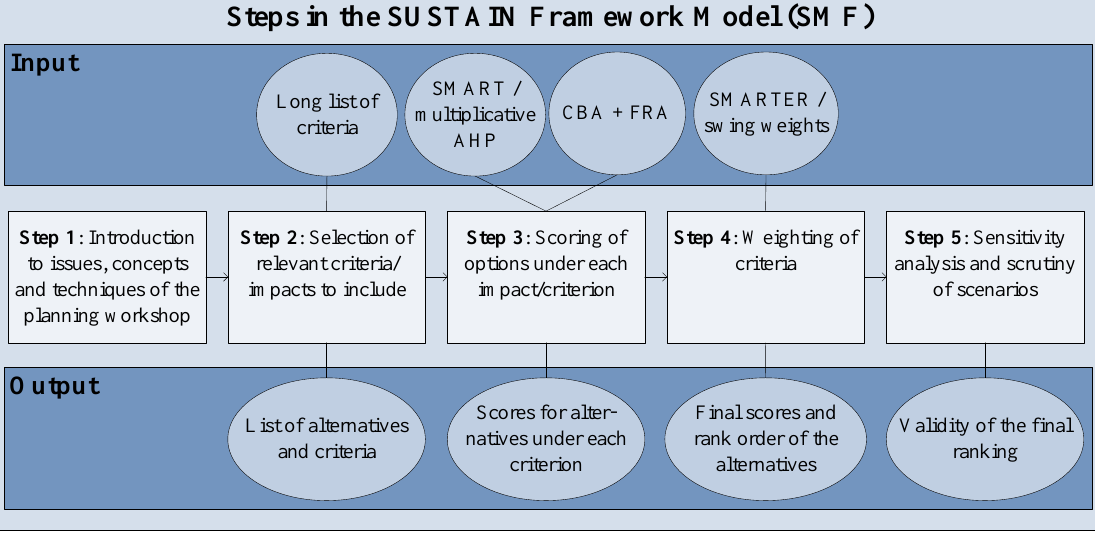
Figure 4. The 5 steps of the Framework model (adapted from Barfod (2012a) and Barfod and Salling